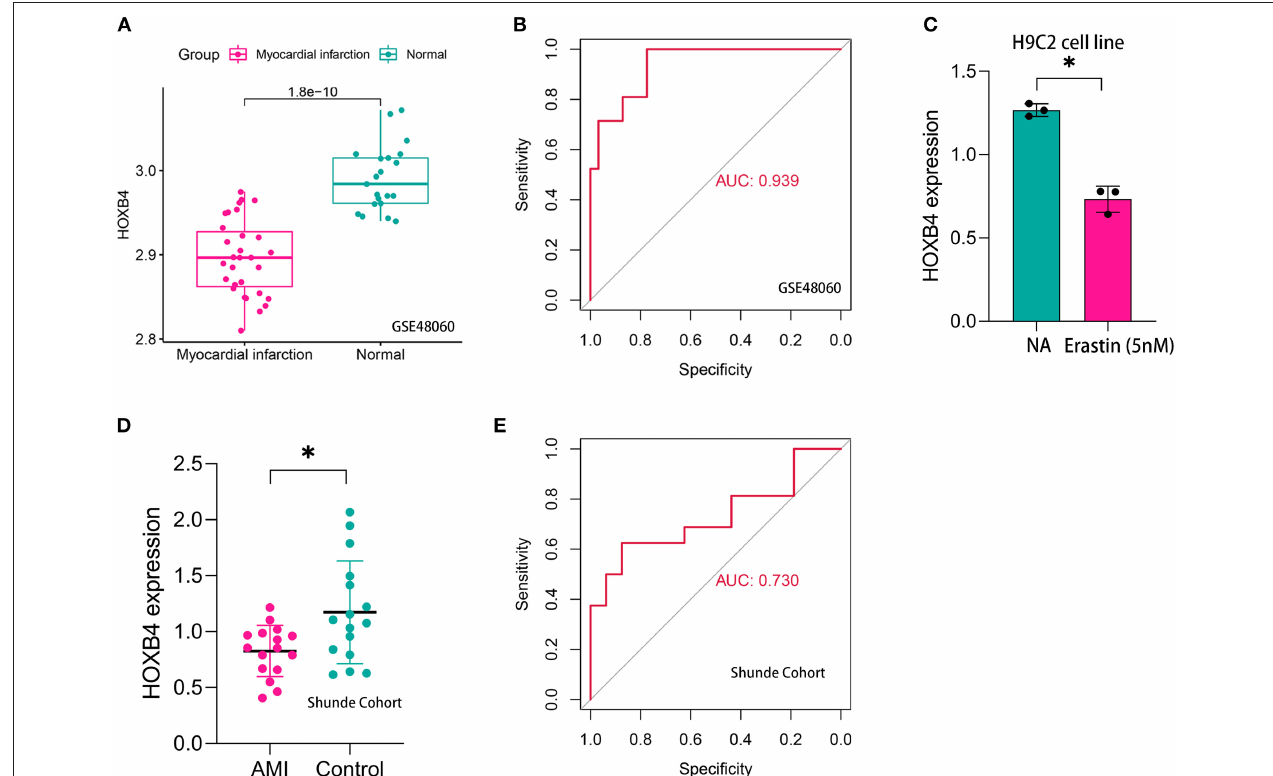
FIGURE 5 | HOXB4 was a ferroptosis-related biomarker for acute myocardial infarction (AMI) diagnosis. (A) HOXB4 was significantly downregulated in the AMI samples of the GSE48060 cohort. (B) The receiver operating characteristic (ROC) curve for the diagnostic value of HOXB4 in GSE48060. (C) HOXB4 was downregulated in H9C2 cells treated with 5nM erastin. (D) HOXB4 was significantly downregulated in the AMI samples of the local cohort. (E) The ROC curve for the diagnostic value of HOXB4 in the local cohort. * p < 0.05.